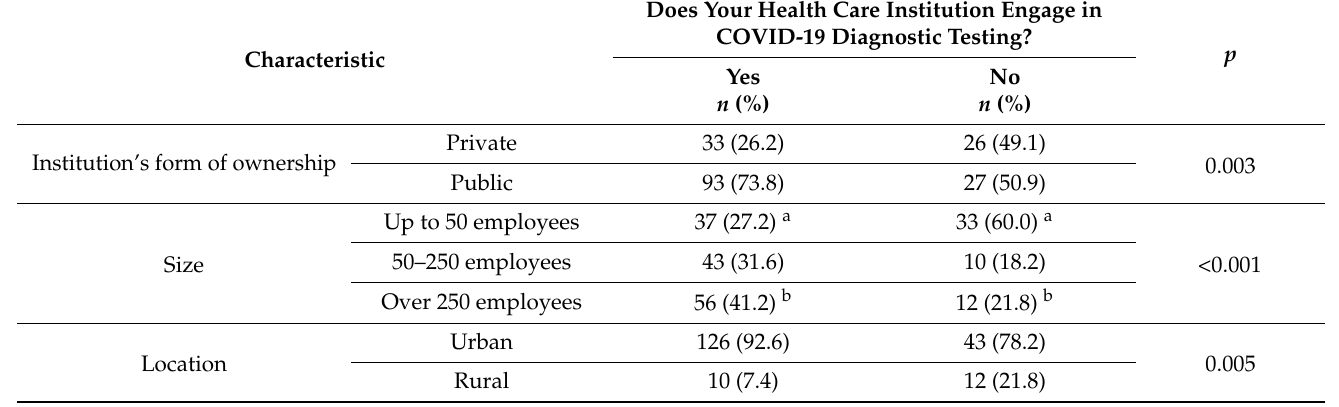
Table 7. Relationships between the sociodemographic characteristics of respondents and diagnostic testing for COVID-19.